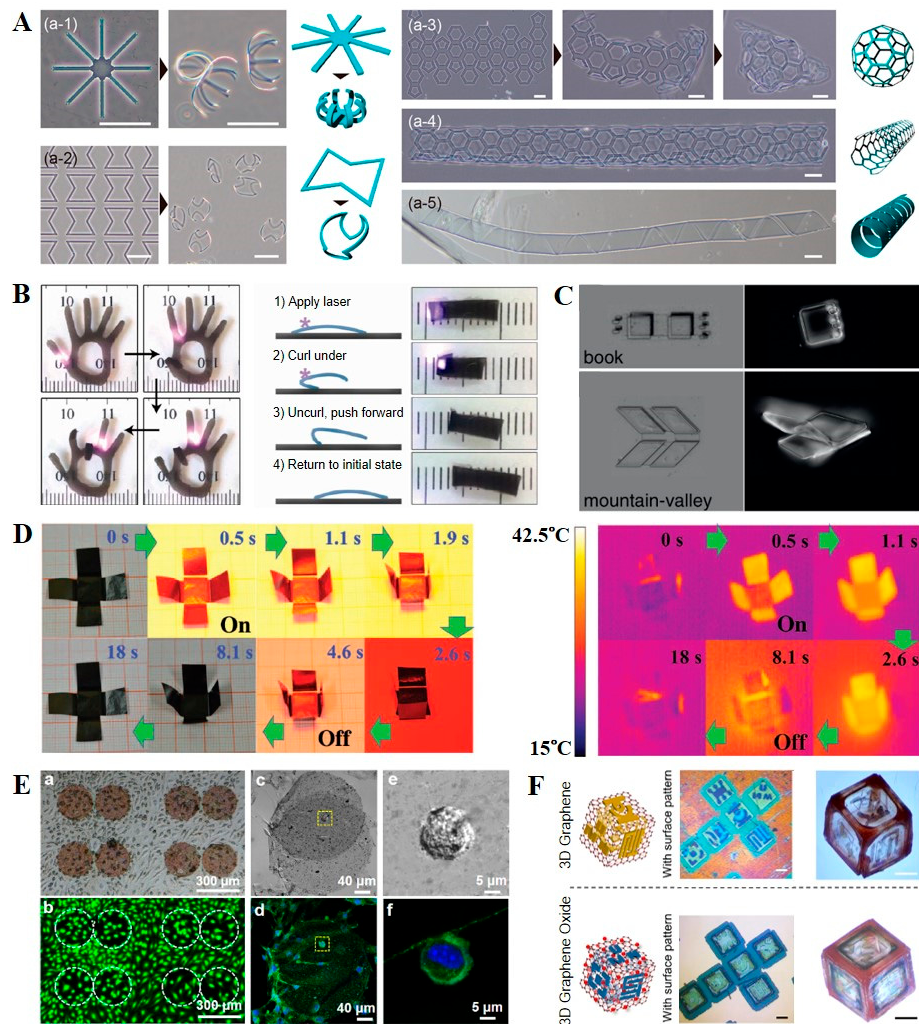
Figure 3. ( A ) Spontaneously bending or rolling thin poly (chloro-p-xylylene) (parylene-C) film